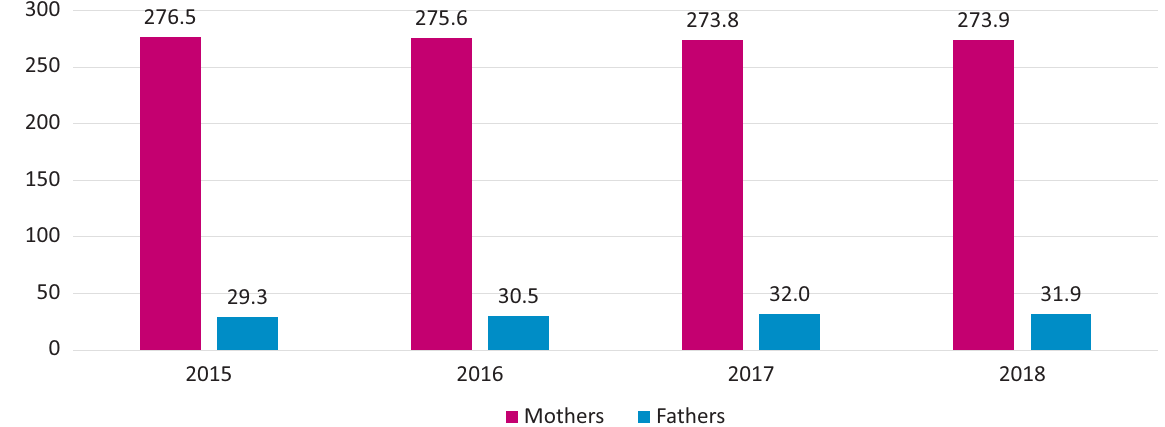
Figure 6. Number of parental leave days (average, fathers and mothers; Denmark, 2015‒2018). Note: Cohabiting parents